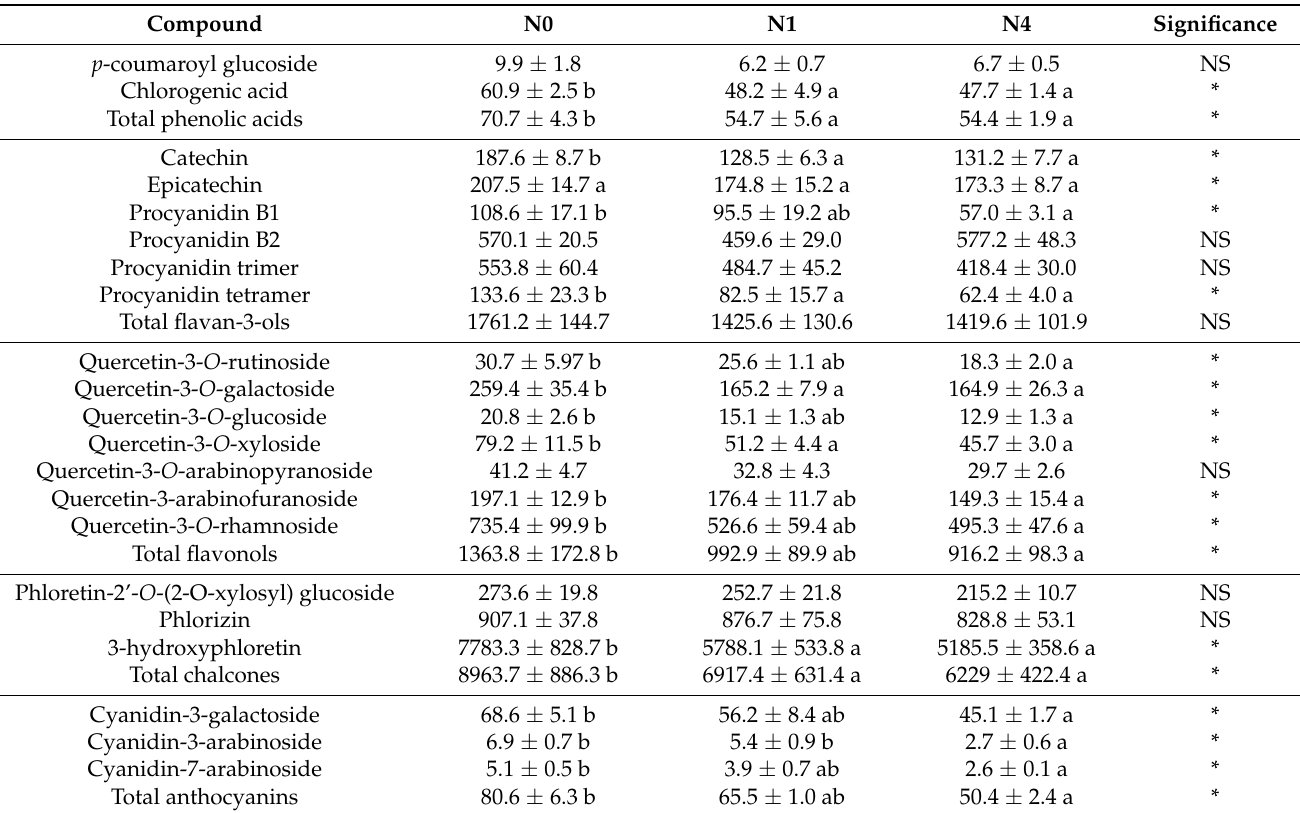
Table 3. Phenolic compounds ( µ g g − 1 FW) of ‘Topaz’ apples subject to three urea treatments.